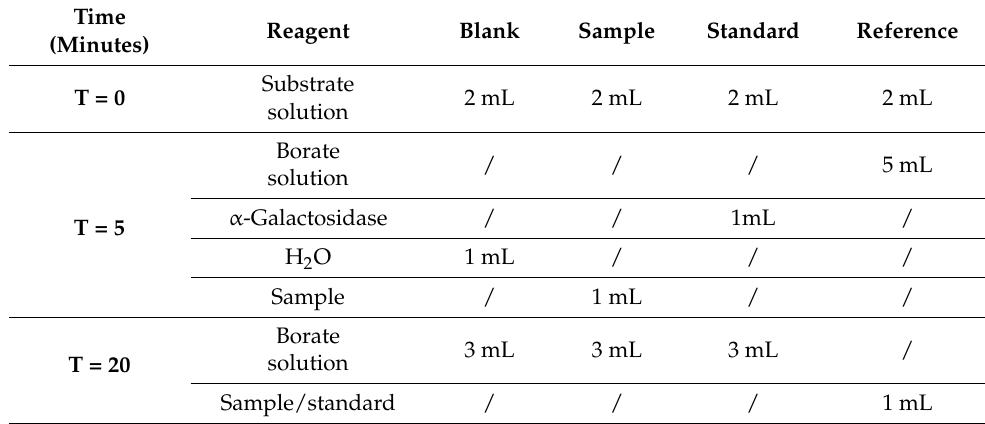
Table 6. Summary of the assay’s workflow